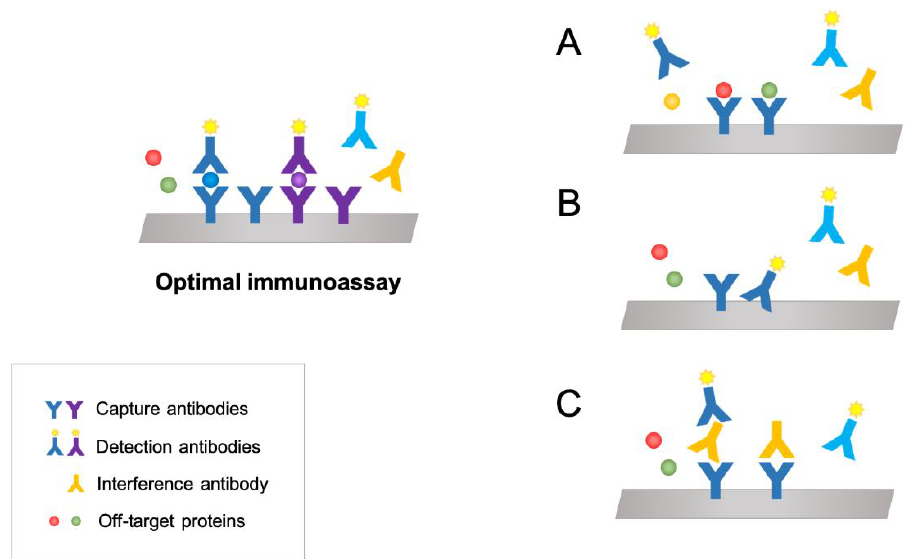
Figure 1. Potential sources of interference in multiplex immunoassays; ( A ) antibody cross-reactivity, ( B ) non-specific antibody binding and ( C ) antibody interference.